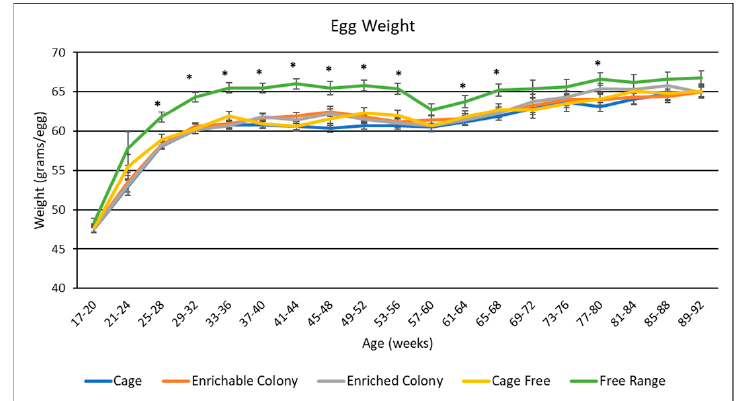
Figure 5. The effect of housing system on egg weight of brown egg layers by age. * Signifies a significant effect ( p < 0.05) of housing environment by age range on egg weight.